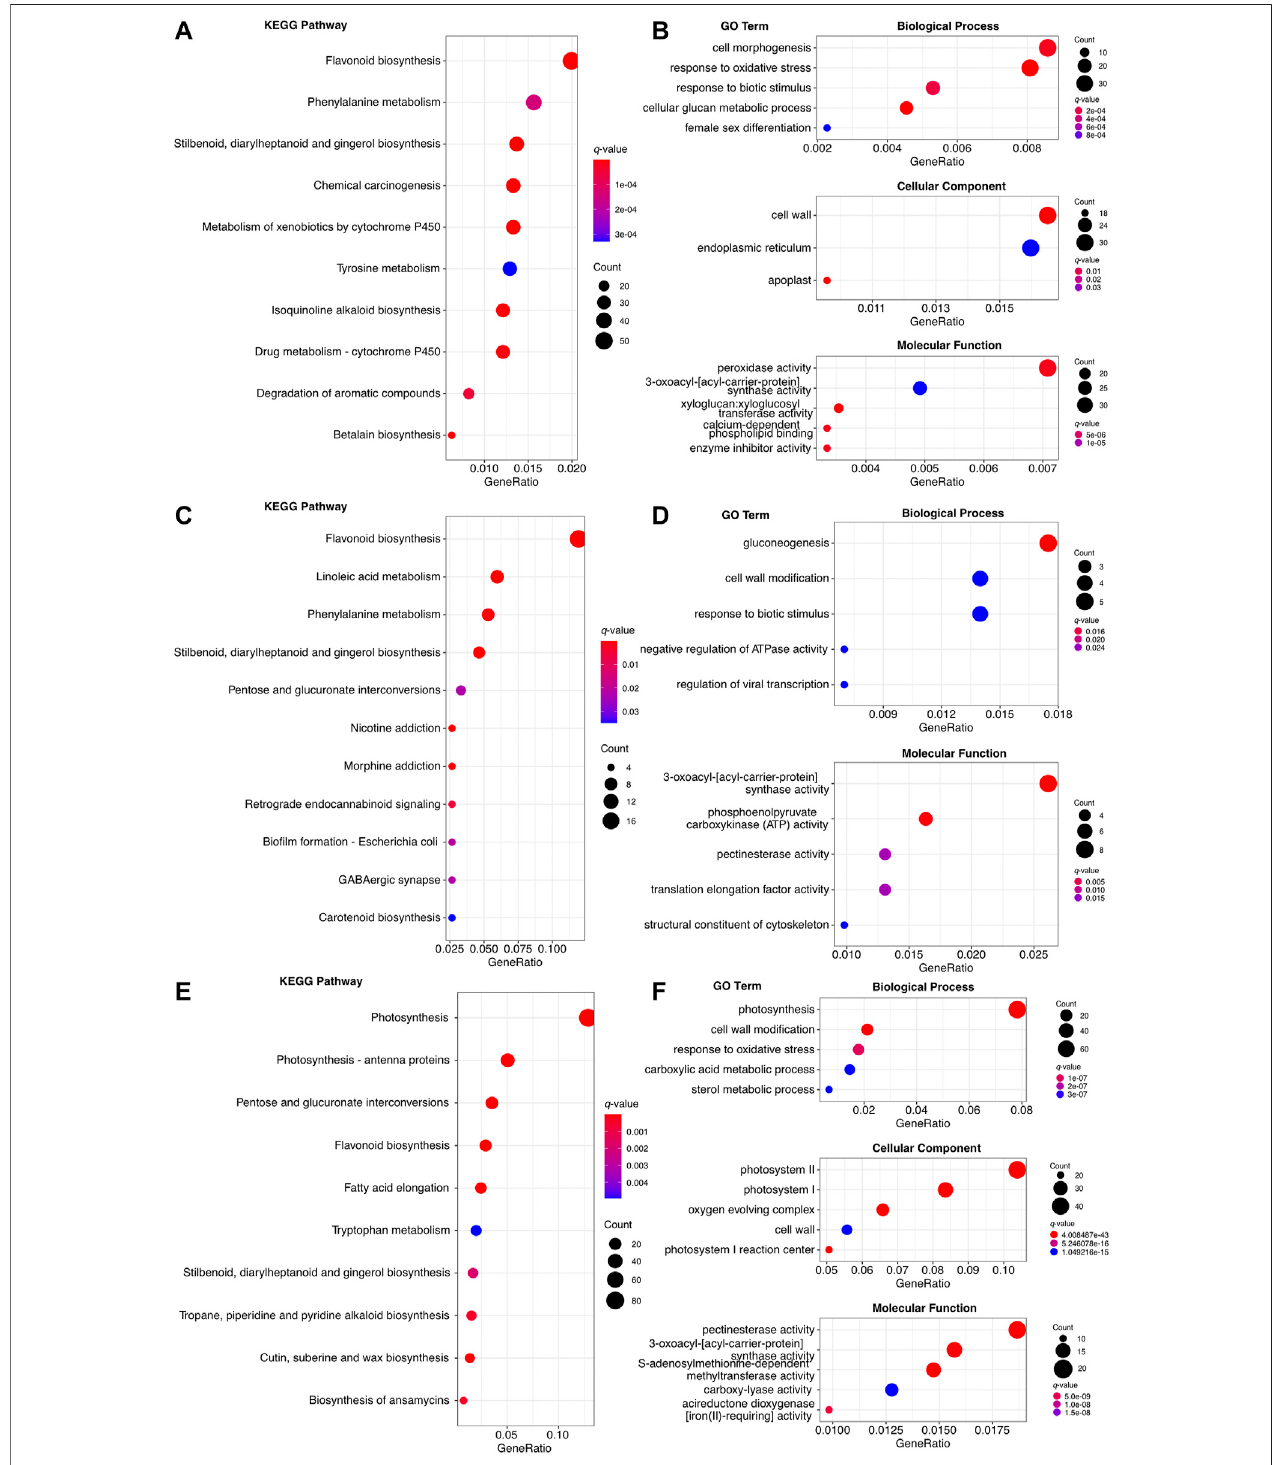
FIGURE4| TheKEGGandGOenrichmentanalysisoforgan-speci fi cupregulatedgenes. (A) Thetoptenenriched KEGGpathways in8,211upregulated genesof root. (B) The top ten enriched KEGG pathways in 638 upregulated genes of rachis. (C) The top ten enriched KEGG pathways in 1707 upregulated genes of pinna. (D) The top fi veenriched GOtermofeach level1category in8,211upregulatedgenesofroot. (E) Thetop fi ve enriched GOterm ofeach level 1categoryin638upregulated genes of rachis. None of the GO terms in the cellular component was enriched. (F) The top fi ve enriched GO terms of each level 1 category in 1707 upregulated genes of